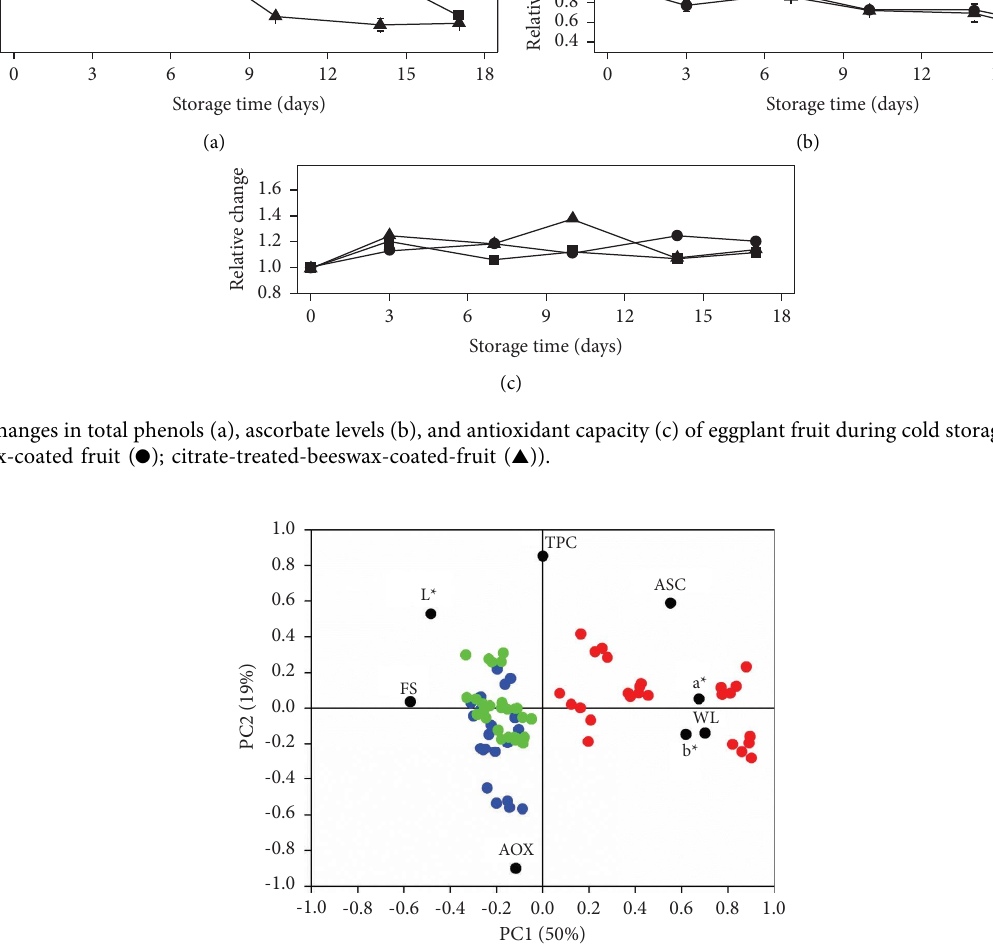
Figure 3: PCA bi-plot (PC1 is plotted against PC2) showing eggplant fruit at the diferent coating conditions. Te samples scores (control fruit-red; beeswax-coated fruit-green; citrate-treated-beeswax-coated fruit-blue) is superimposed on the loadings (AOX-total antioxidant capacity; ASC-ascorbate; FS-frmness; TPC-total phenolic content; WL-weight loss; L ∗ value; a ∗ value; b ∗